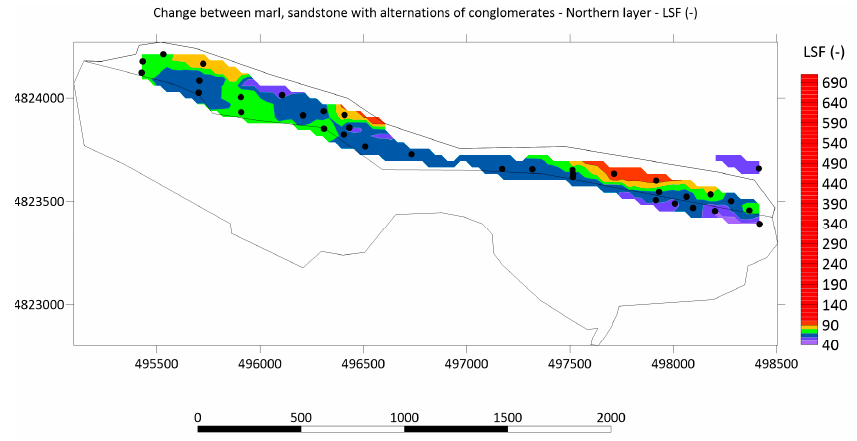
Figure 10. Map of LSF ( − ) in unit (1), northern layer (boreholes are black dots). The three maps in unit (5), in the northern layer, showed values of CaO (%), SiO 2 (%), and LSF ( − ). All were interpolated by ordinary kriging, using the nugget Co = 0, sill C(CaO) = 1, C(SiO 2 ) = 1, C(LSF) = 15,000, range a = 320 m, total calculation distance h = 1033 m, number of classes 17, and tolerance 45 ◦ . The experimental variogram was approximated with the exponential model (Figure 11). The searching ellipsoid had axes of 320 × 50 m with strikes − 15 ◦ and 105 ◦ and an anisotropy factor 6.4. The maps of CaO (%), SiO 2 (%), and LSF ( − ) are shown in Figures 12–14.